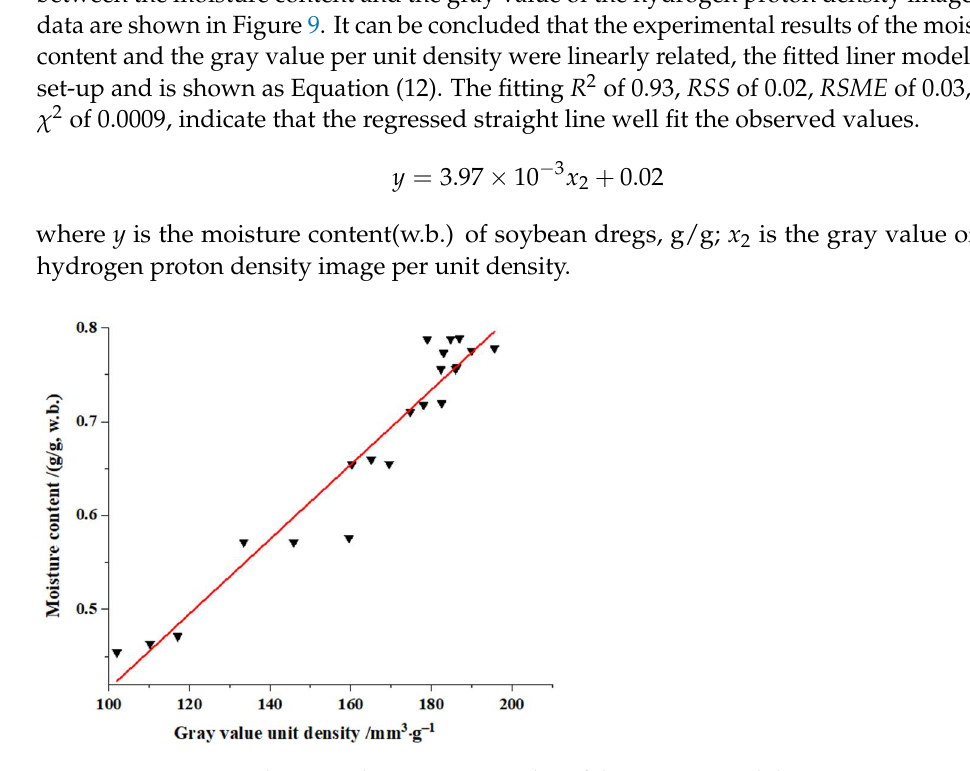
Table 2. Comparison of the predicted and measured moisture content of soybean dregs. Drying Measured Moisture Time/h Content/(g/g, w.b.)